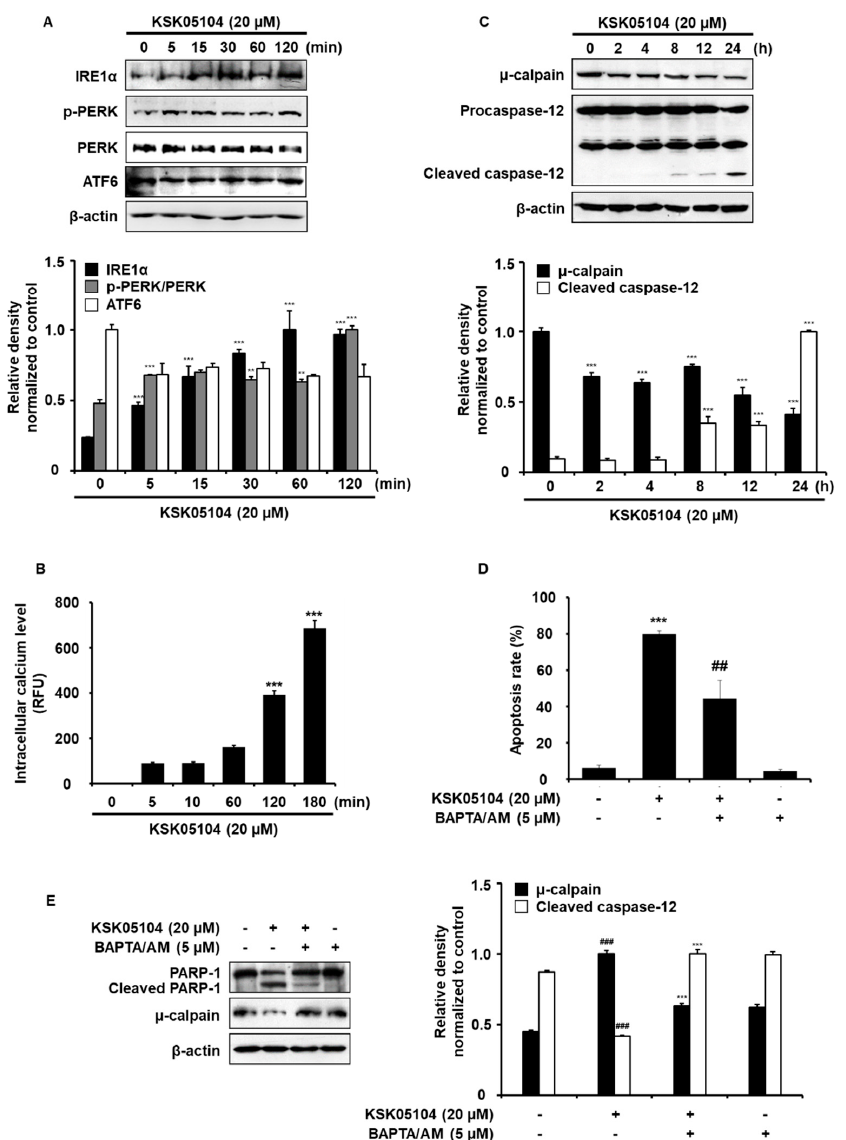
Figure 6. Effect of KSK05104 on endoplasmic reticulum (ER) stress and Ca 2+ -mediated apoptosis in HT-29 cells. ( A ) Cells treated with 20 µ M KSK05104 for 2 h. Western blot analysis was conducted using antibodies against IRE-1 α , p-PERK, PERK, and ATF6. β -actin was used as internal control. Ratio of relative density was determined by a densitometric analysis program (Bio-rad Quantity One ® Software) normalized to internal control; ( B ) Cells were treated with 20 μ M KSK05104 for the indicated times, and the level of the [Ca 2+ ] i was determined using a Fluo-4/AM fluorescence kit. The stained cells were analyzed using fluorescence; ( C ) Cells treated with 20 μ M KSK05104 for 24 h. Western blot analysis was conducted using antibodies against μ -calpain and caspase-12. β -actin was used as internal control; ( D ) Cells were pretreated with 5 μ M BAPTA/AM for 1 h and then treated with or without 20 μ M KSK05104 for 24 h. Cells were co-stained with PI and FITC-conjugated Annexin V, and the translocation of PS was detected via flow cytometry; ( E ) Cells pretreated with 5 μ M BAPTA/AM for 1 h and then treated with or without 20 μ M KSK05104 for 24 h. Expression of PARP-1 and μ -calpain were examined via Western blot analysis. β -actin was used as internal control. Data presented as means ± S.D. of the results of three independent experiments. ** p < 0.01 *** p < 0.001 vs. non-treated control group, ## p < 0.01, ### p < 0.001 vs. KSK05104-treated control group.